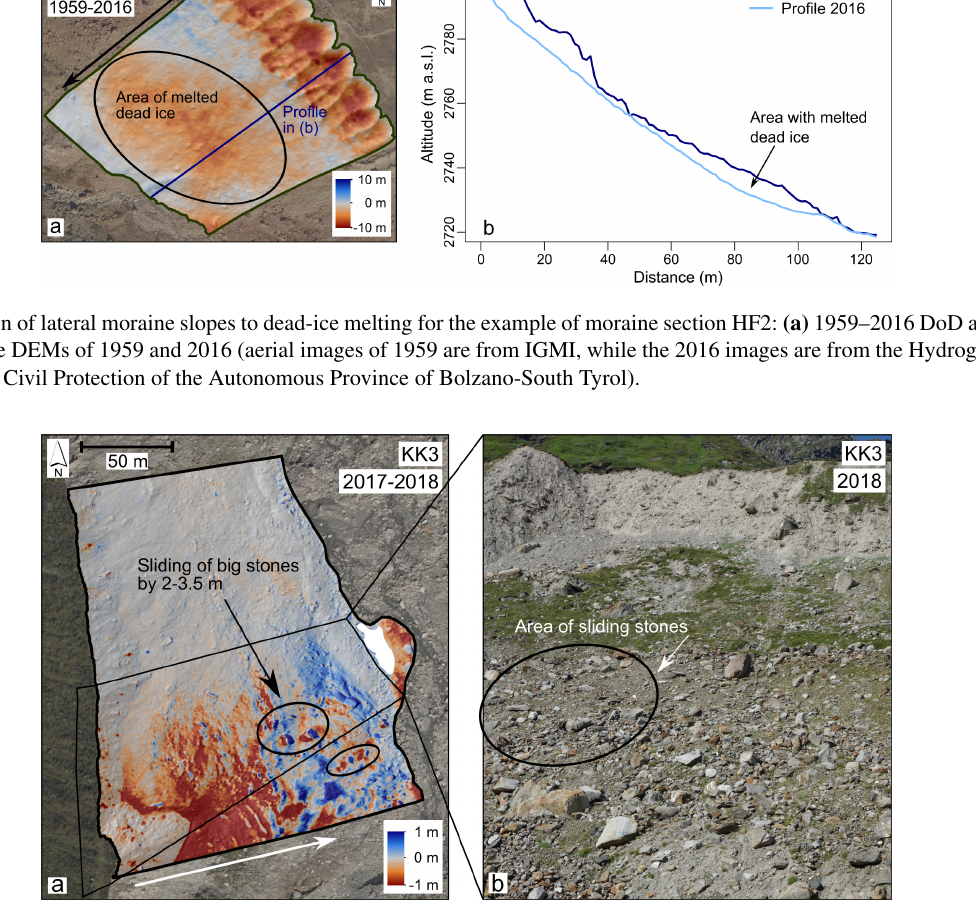
Figure 6. Reaction of lateral moraine slope to dead-ice melting for the example of moraine section KK3: (a) 2017–2018 DoD and (b) image taken from the foot of the moraine slope towards the ridge on 1 August 2018, a rough outline of which is marked in (a)